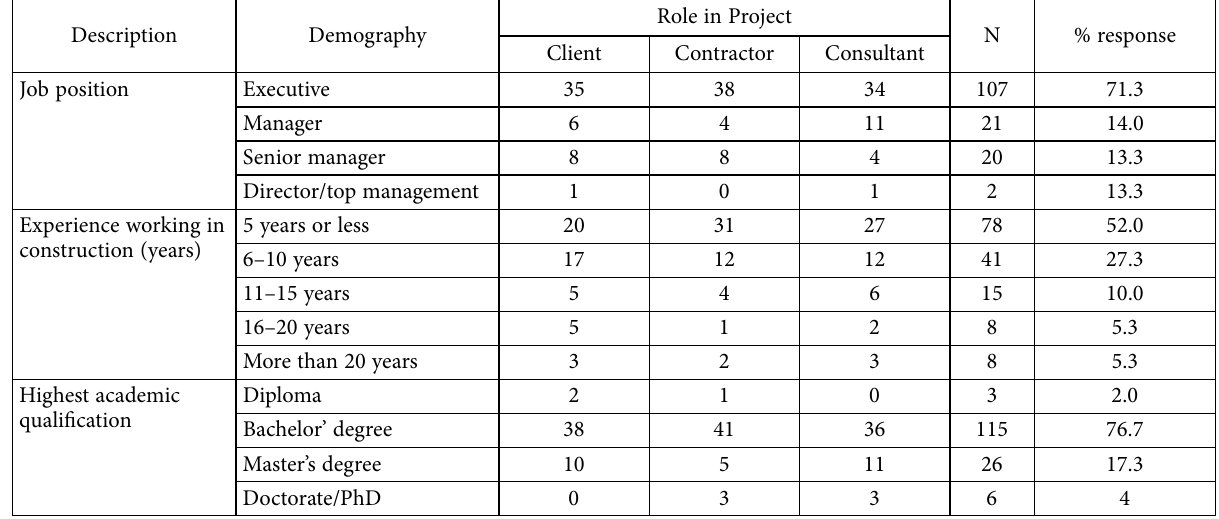
Table 2. Demographic profile of